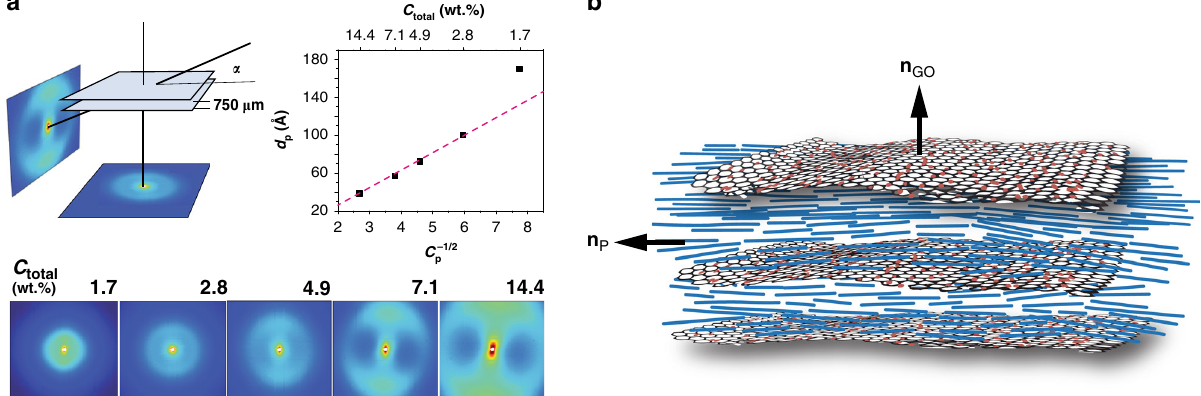
Fig. 2 Characterization of PBDT + GO hybrid nematics. a Small angle X-ray scattering from fl uid PBDT + GO mixture contained in a transmission cell (parallel mica windows separated by a 750 μ m spacer) for α ≈ 15 ° ( “ edge-on ” ) and α = 90 ° (normal incidence). In the hybrid phases the scattering from the PBDT is easily distinguished from scattering due to GO platelets; the former is at larger scattering angles 8 and the latter, dominated by GO scattering, is adjacent to the beam-stop. The non-uniform azimuthal intensity in the α ≈ 15 ° scattering from the h N b phase ( C total = 4.9, 7.1, and 14.4 wt.%) derives from a combination of fl ow-induced orientation on preparing the cell and preferential anchoring of both components of the h N b phase. The inter-rod spacing d P for PBDT in the (biphasic) h N b phase appears to be well behaved exhibiting a d P = C P − 1/2 scaling relationship; the unstable GO dispersion in the isotropic mixture ( C total = 1.7 wt.%) deviates from the scaling relationship. b A schematic diagram of the strati fi ed supramolecular arrangement in a single monodomain of the h N b phase wherein the directors n GO and n P are